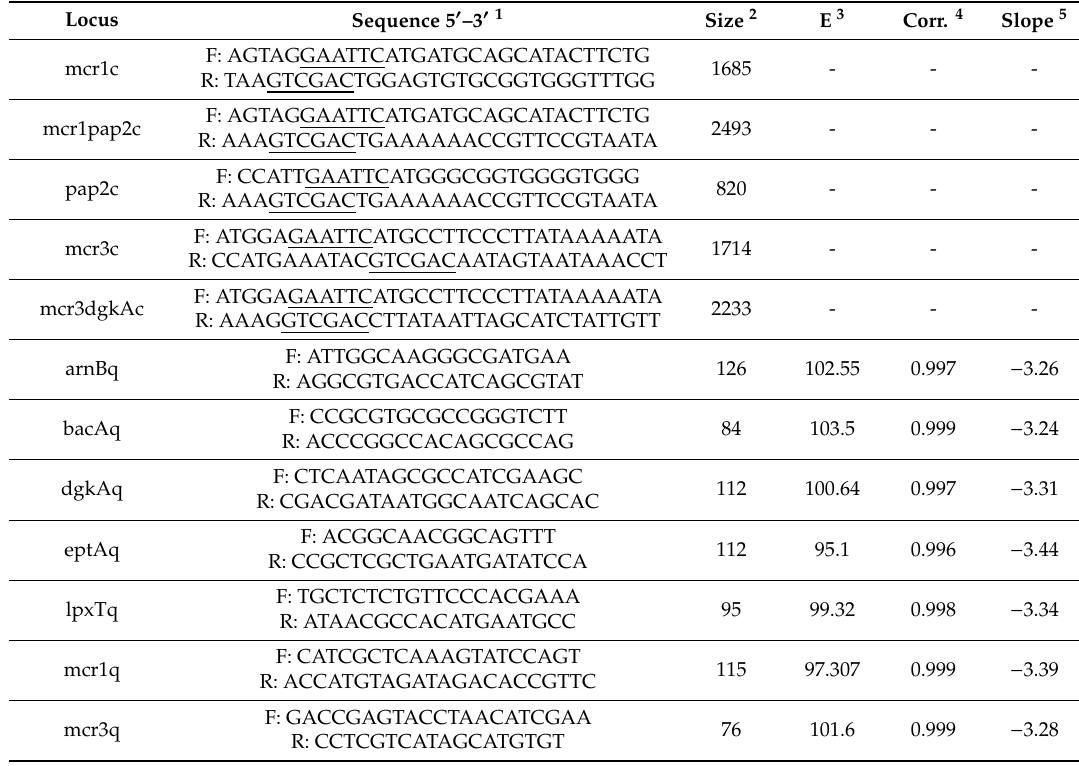
Table 1. Primer pairs and qPCR